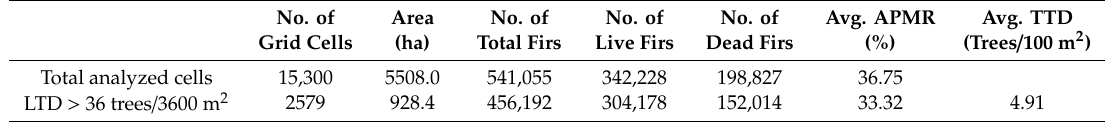
Table 11. Distribution area of the Korean fir on Mt.